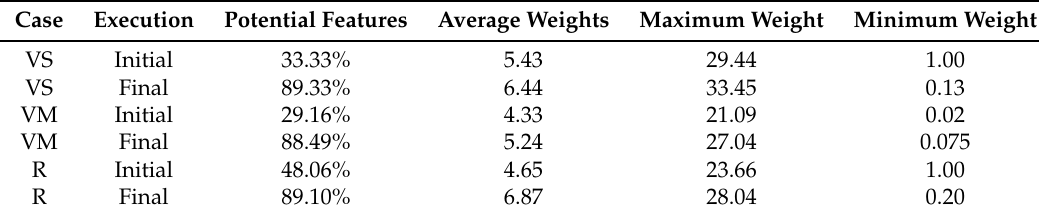
Table 1. Results of the feature-selection procedure.